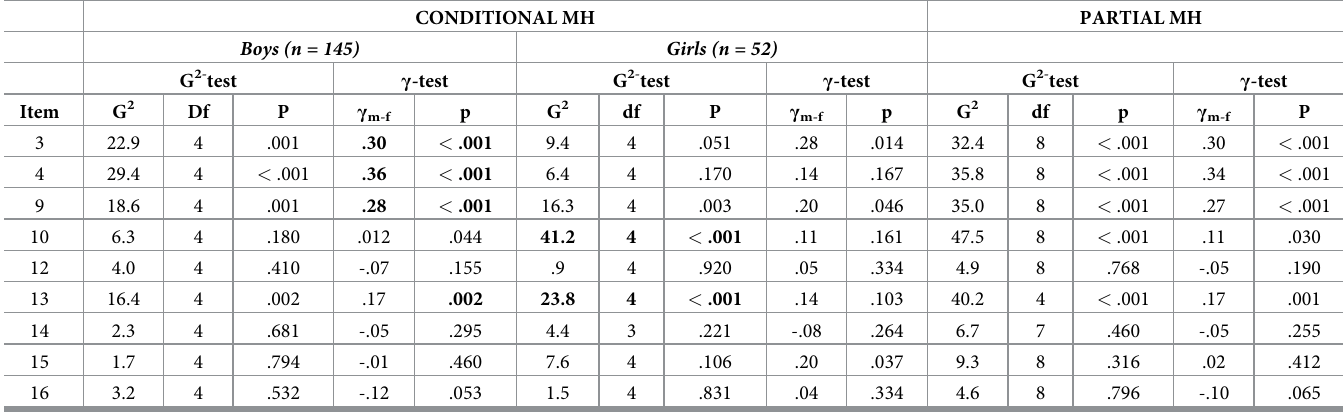
Table 3. Test for marginal homogeneity between mothers’ and fathers’ responses conditioned child gender. CONDITIONAL